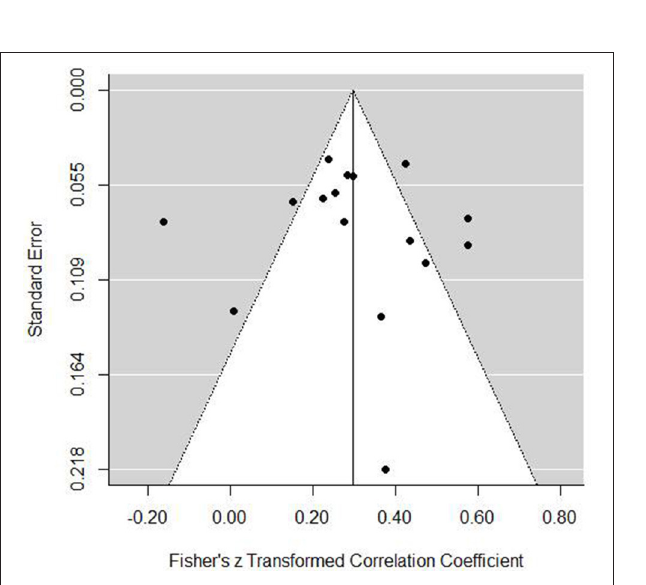
FIGURE 3 | Mastery coping funnel plot.